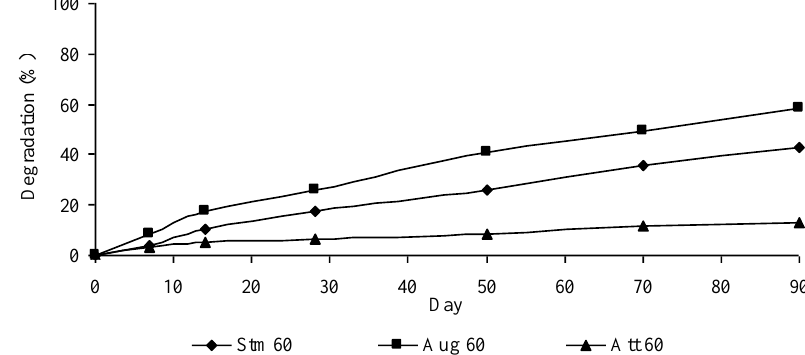
Fig. 3 demonstrated degradation percentage in 90 days for oil concentration of 60 g.